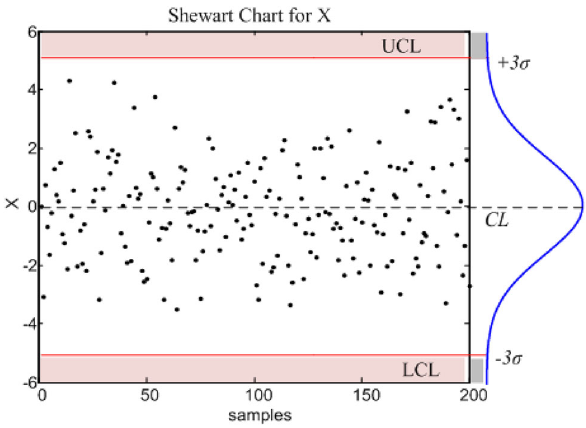
Fig. 1 Univariate Shewhart control